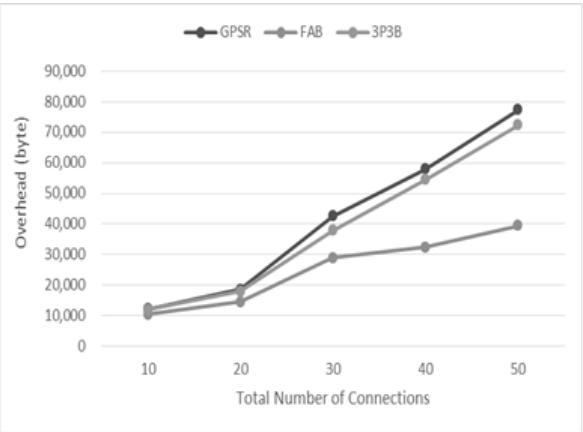
Fig. 8. The overheads for FAB, GPSR, and 3P3B with various connections.